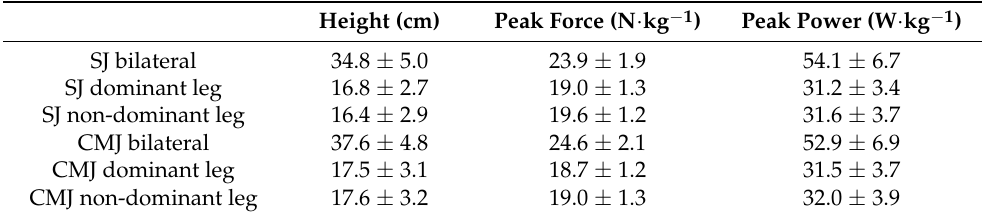
Table 1. Descriptive data (mean ± standard deviation) of the unilateral and bilateral vertical jumps.